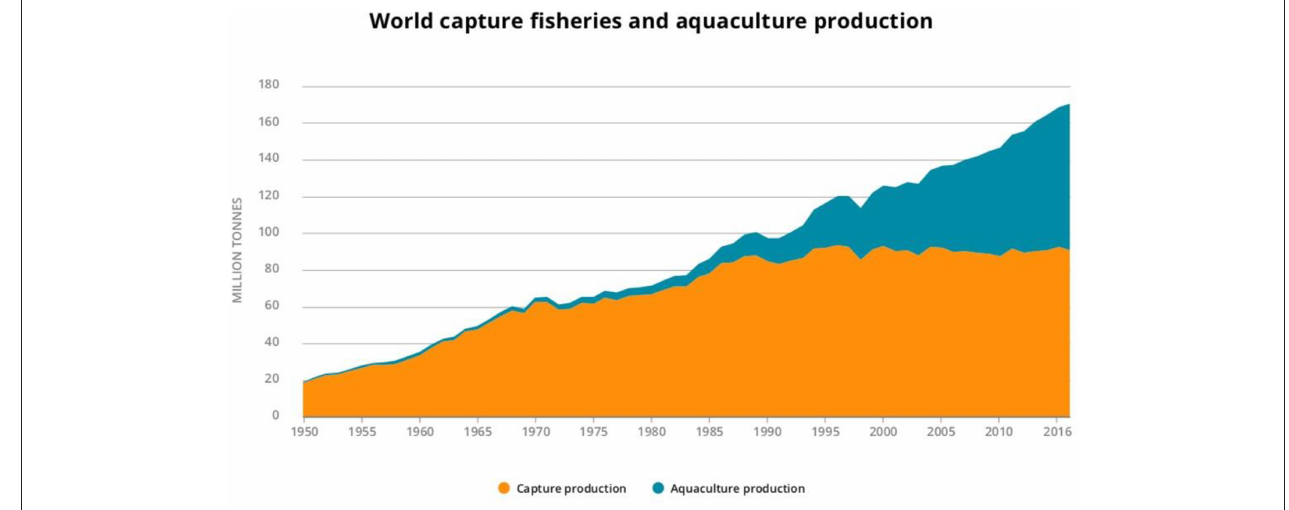
FIGURE 2 | Time history of fish caught and produced by aquaculture. From FAO,